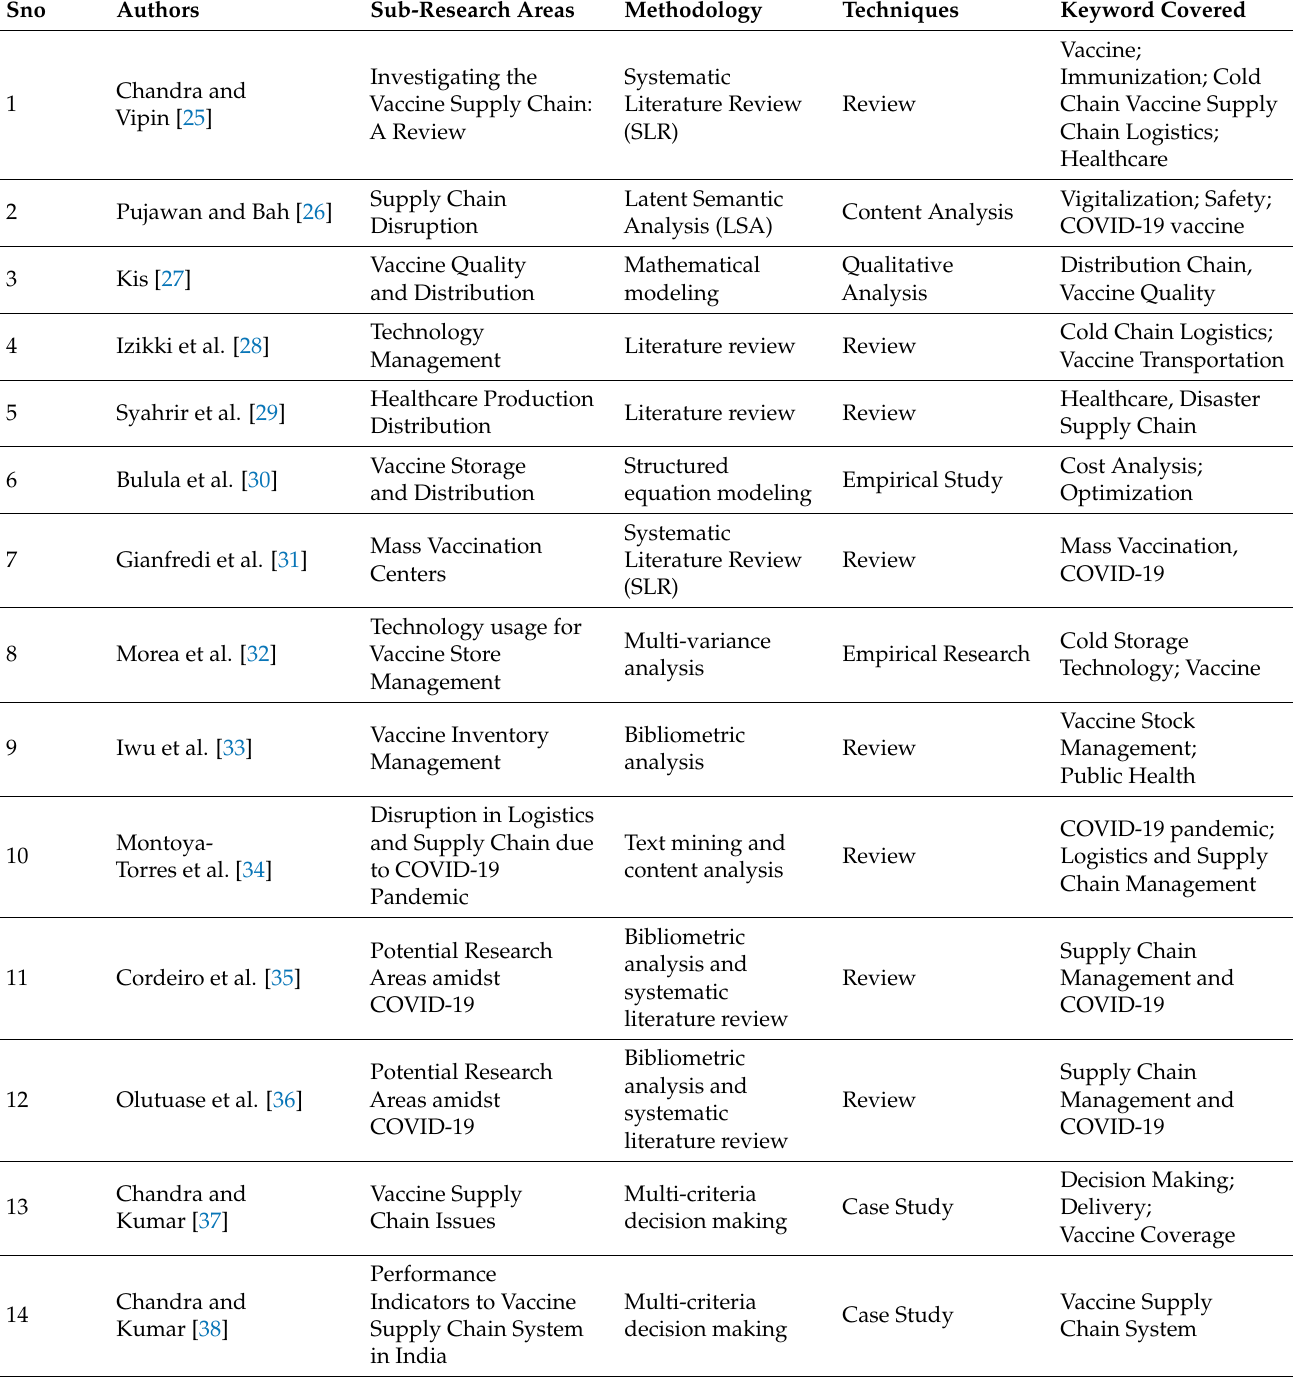
Table 4. Comprehensive Literature review: Sub-research areas, methodology, techniques,